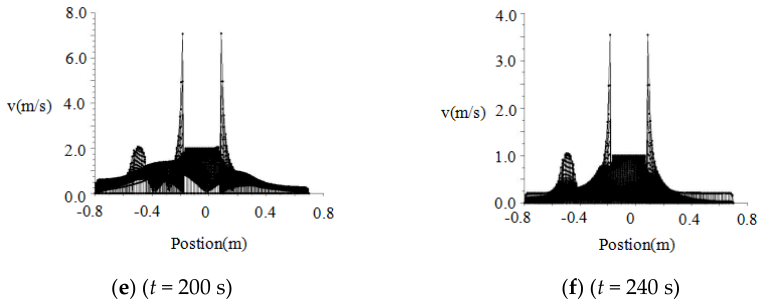
Figure 12. Effect of falling height on particle velocity distribution.